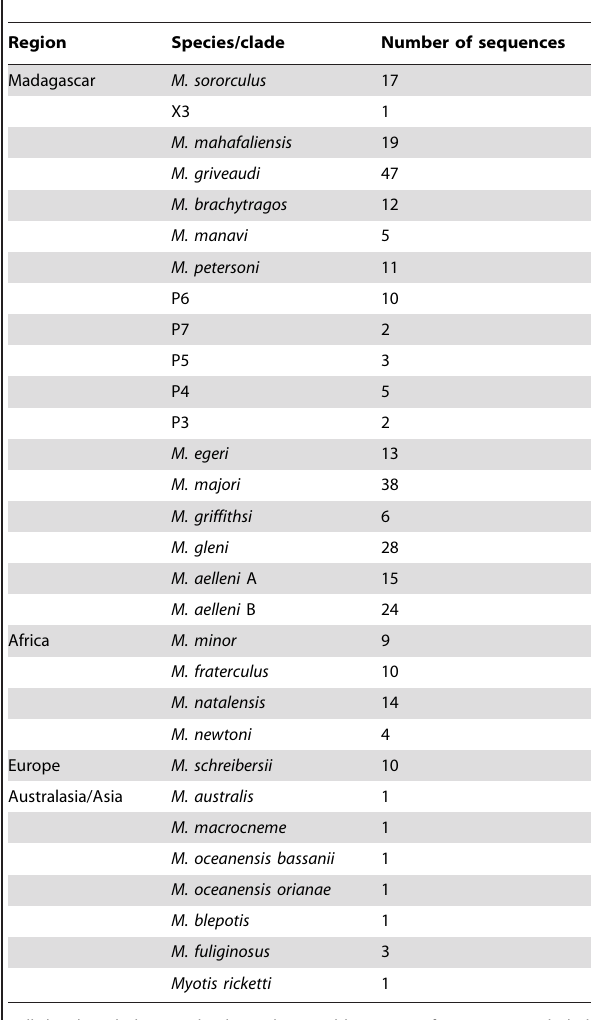
Table 1. Number of cyt- b sequences by taxon and region included in the present study; with one exception all belong to the genus Miniopterus